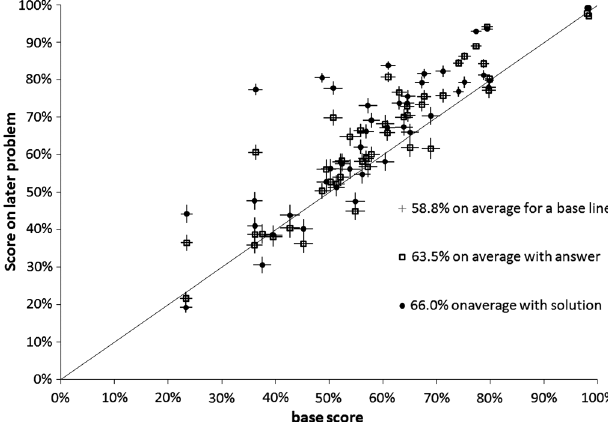
FIG. 2. Results for the 22 groups of paired problems. The horizontal axis is the baseline score for the problem from the two groups that saw the question first, the vertical axis shows performance by students seeing the problem second. These two groups are separated based on if they had access to the complete solution for the paired problem or only the answer. See the appendix for more